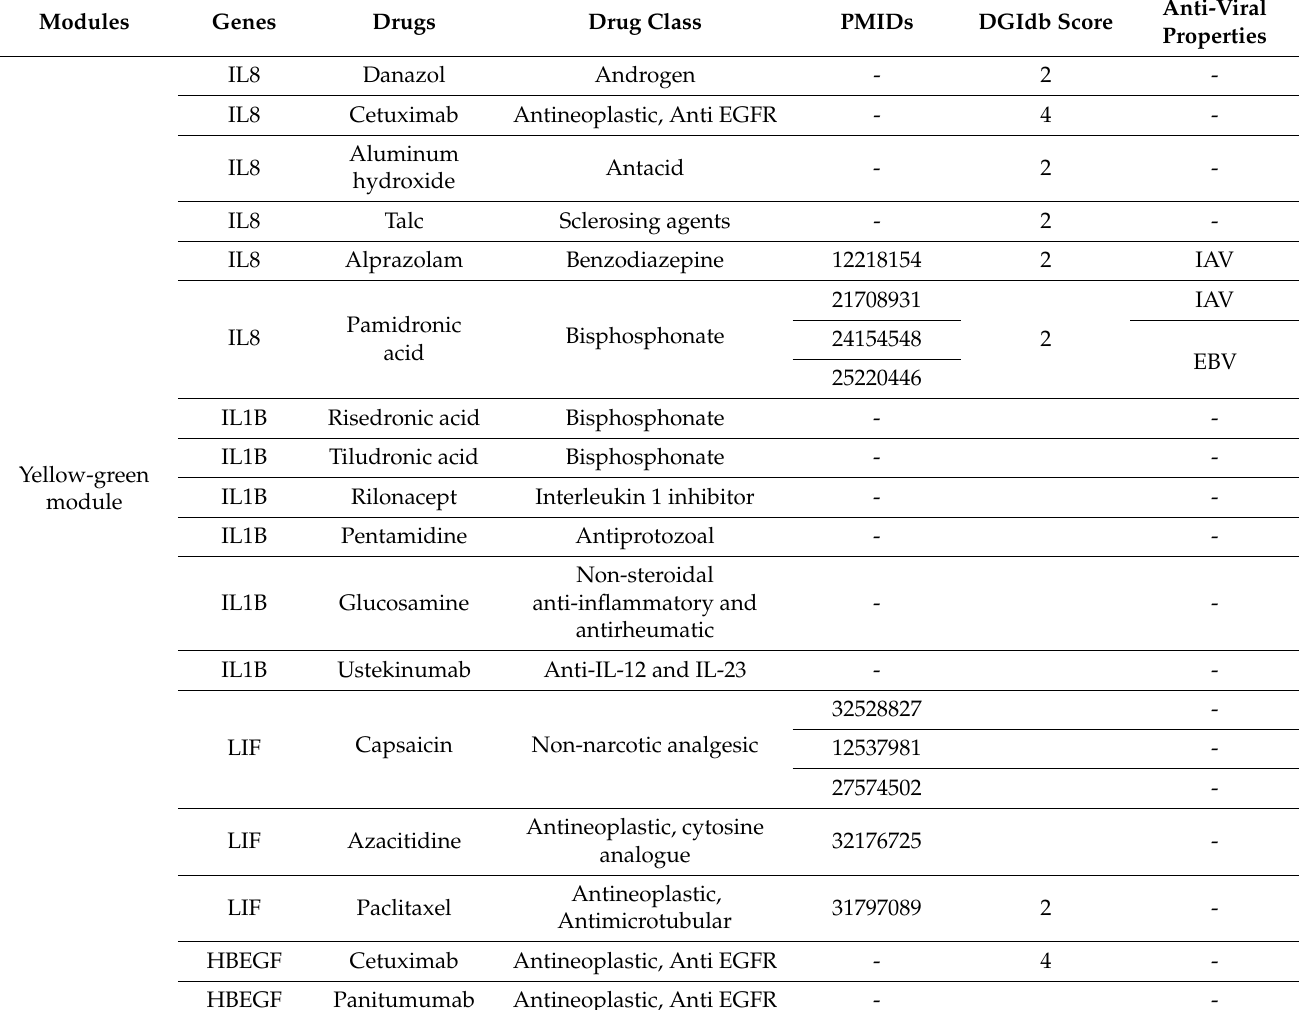
Table 2. Novel potent drugs with literature-derived anti-viral evidence for COVID-19 drug repositioning. Modules